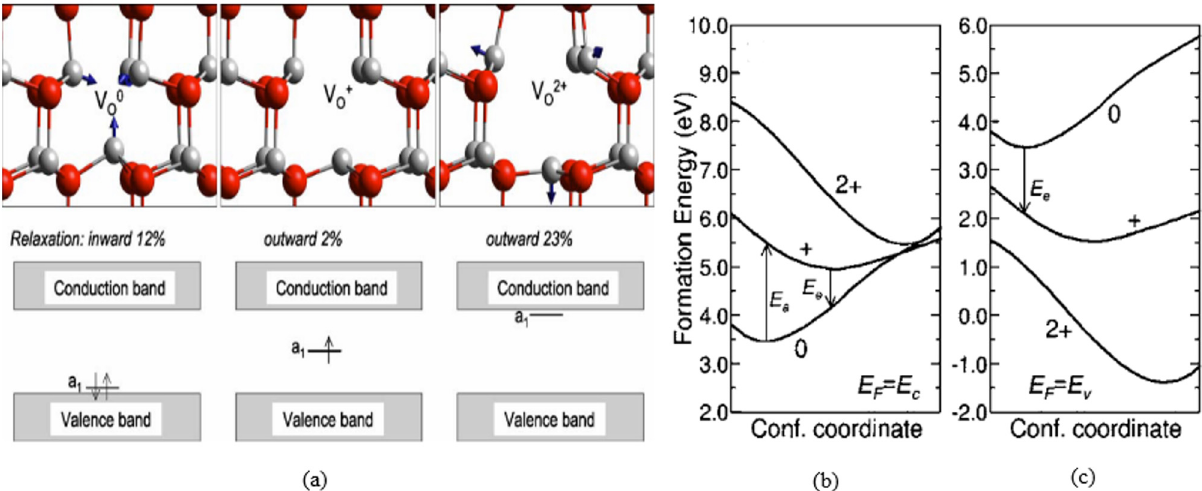
Figure 12: ( a ) The atomic relaxations surrounding the oxygen vacancy in di ff erent charge states. For each charge state ’ s equilibrium con fi guration, the location of the a 1 state is also displayed. ( b ) Presence of Fermi energy in di ff erent charge states at conduction band minimal. ( c ) Presence of Fermi energy in di ff erent charge states at valence band maximum. Reproduced with permission from Elsevier [ 57 ]